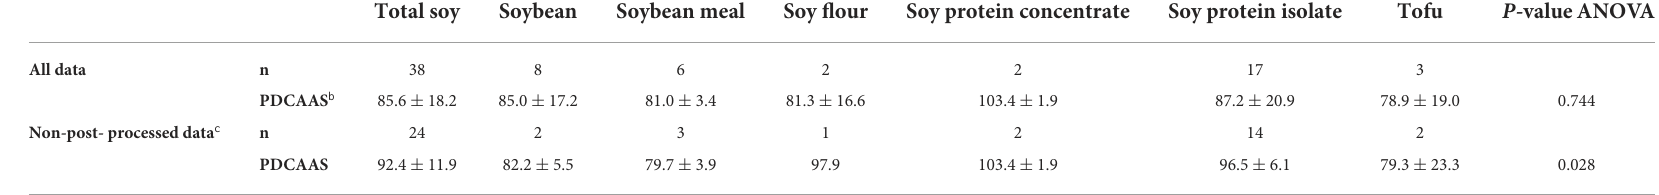
TABLE 5 PDCAAS (%) a (mean ± SD) for total soy and soy product groups calculated from all available data and after excluding post-processed soy products